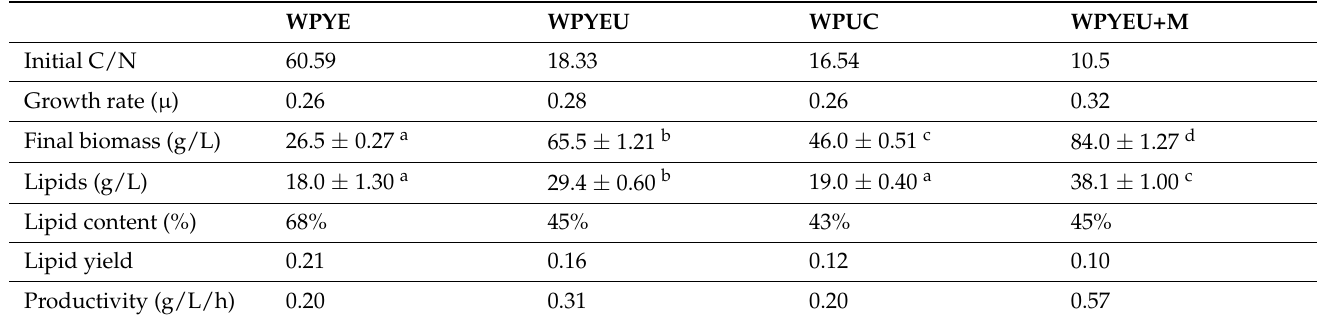
Table 2. ATCC 20509 growth and production parameters calculated at the final point of process in different WP-based media. Samples indicated with a different letter are significantly different ( p < 0.05) according to one-way ANOVA with post hoc Tukey HSD